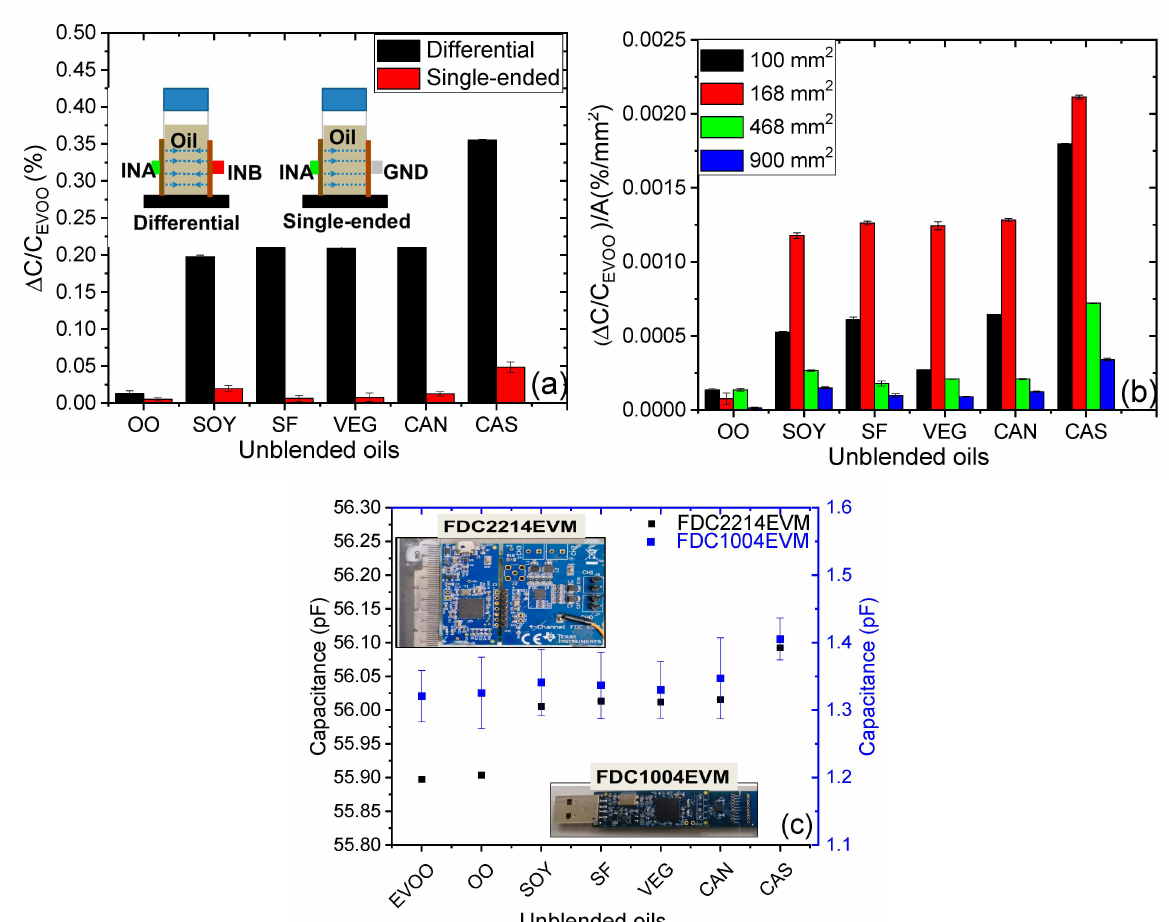
Figure 4. Sensing methodology optimization: ( a ) ∆ C EVOO /C EVOO ( ± σ ) for single-ended vs. differen- tial FDC2214 sensor configuration (schematic of sensing configuration in inset); ( b ) ∆ C EVOO /C EVOO ( ± σ ) (Normalized by sensor area) vs. electrode area; ( c ) Absolute capacitance ( ± σ ) comparison plot for FDC1004 and FDC2214 (photographs of FDC2214 and FDC1004EVM in inset Extra virgin olive oil − EVOO, olive oil − OO, soybean oil − SOY, sunflower oil − SF, vegetable oil − VEG, canola oil − CAN and castor oil −